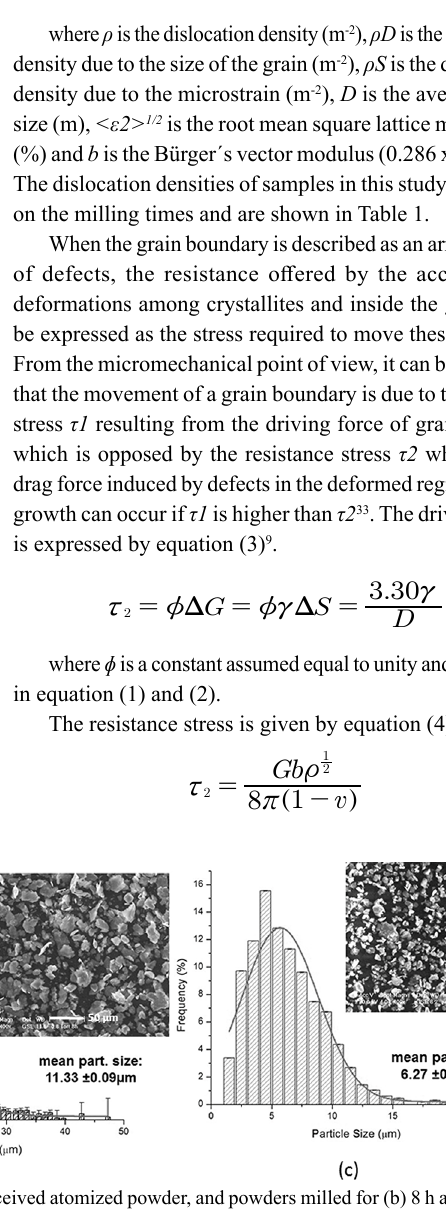
Figure 1. Size of the crystallites and microstrain in the powder as functions of milling time obtained by XRD Analysis.